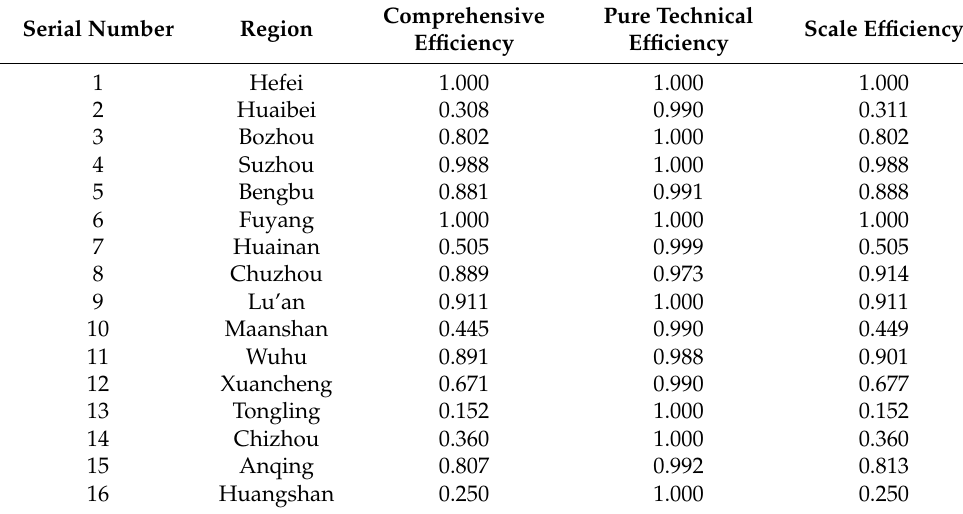
Table 7. DEA estimation results in the third stage: regional